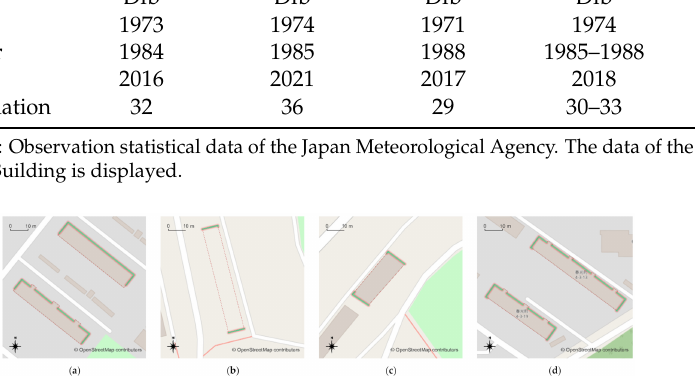
Figure 1. Building layout and external insulation repair position. The green line is the external insulation repair position; all buildings have already been dismantled: ( a ) The lower left building is Bldg. A. The upper right building is Bldg. B. Bldg. A had no external insulation in the staircase projecting from the northeast side wall; ( b ) This is Bldg. C. External insulation was installed on the gable side. External insulation was installed continuously from the gable face to the edge of the nearest window on the east face; ( c ) This is Bldg. D, close to Bldg. C. As with Bldg. C, external insulation was installed on the end surface. External insulation was installed continuously from the gable face to the edge of the nearest window on the northwest face; ( d ) The lower left building is Bldg. E. The upper right building is Bldg. F. In both buildings, the staircase projecting from the outer wall on the northeast side had no external insulation. In addition, external insulation was installed continuously up to the edge of the window on the southwest side, which was closest to the gable.